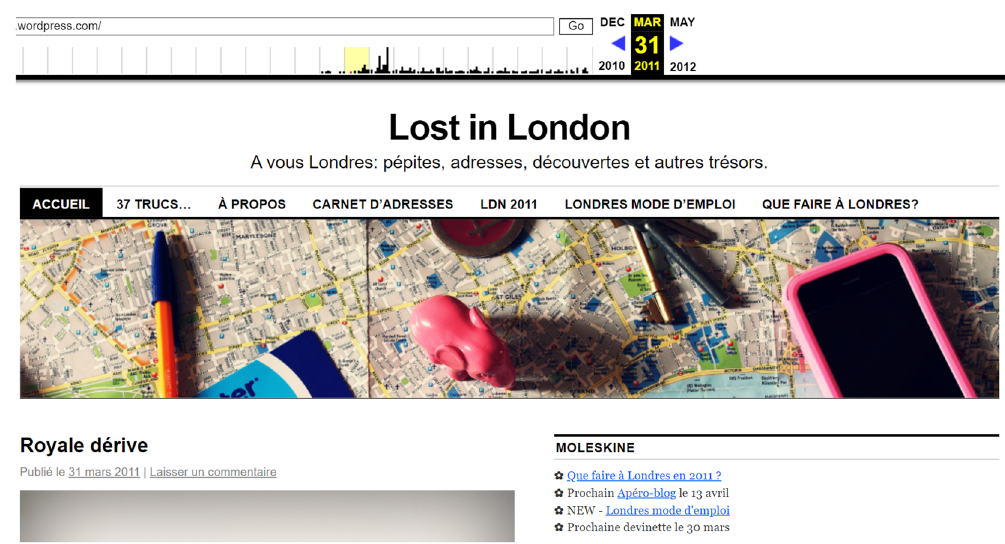
Fig. 3 Lost in London homepage, archived 31 March 2011. The photograph in the banner is culturally and semiotically more nuanced than in the original version of the blog, and there is greater modal interplay between the image and the text. This fi gure is not covered by the Creative Commons